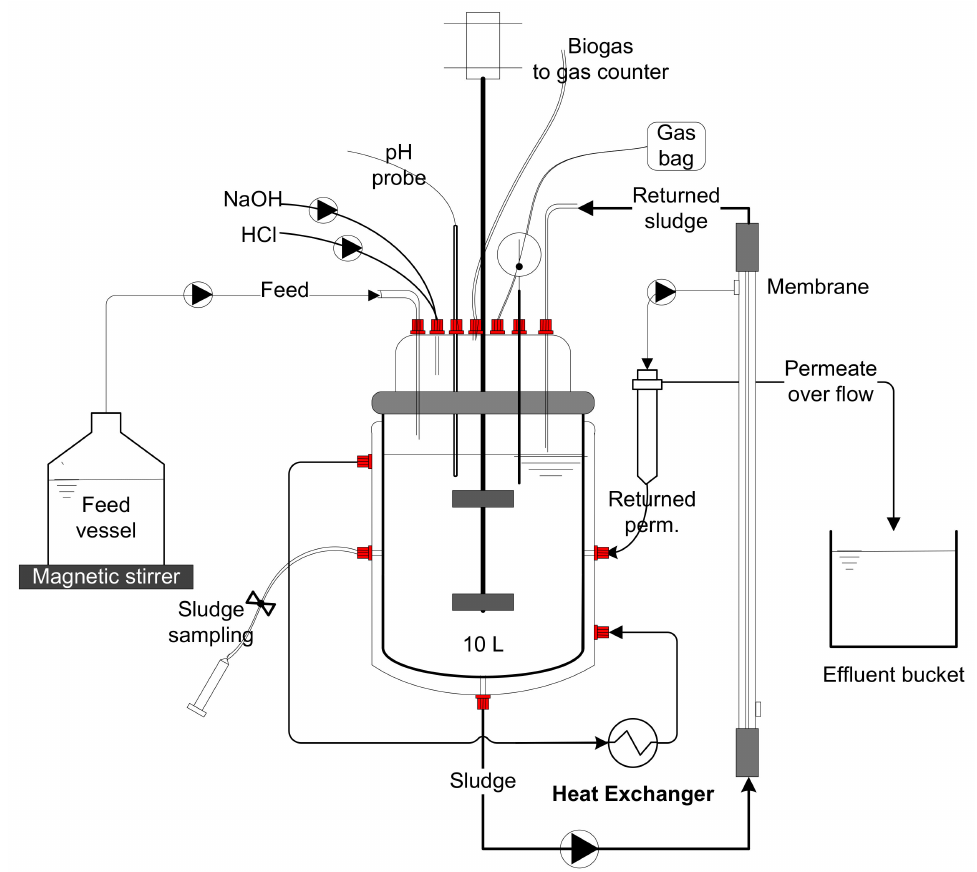
Figure 1. Anaerobic membrane bioreactors (AnMBRs) experimental